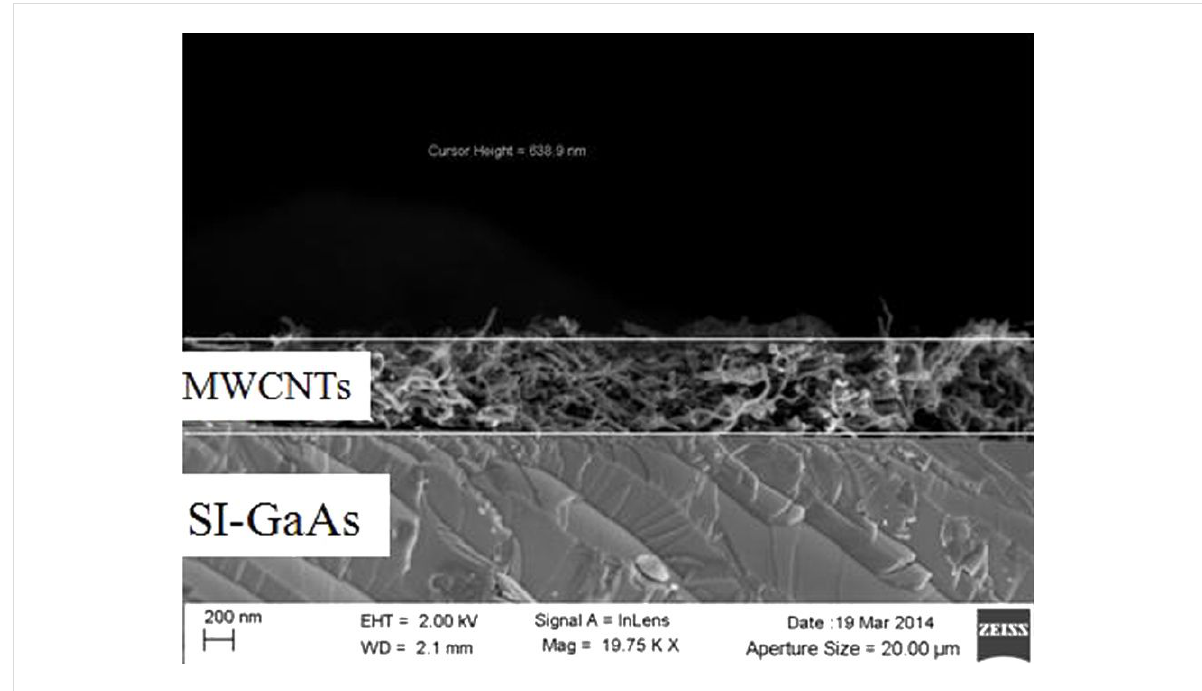
Figure 3: SEM image of the MWCNT film on a semi-insulating gallium arsenide substrate.